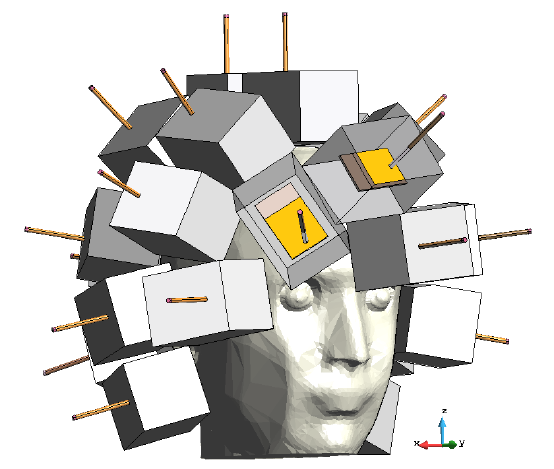
Figure 5. Computer-assisted design (CAD) model of the 3D microwave imaging system together with the anthropomorphic head phantom; two printed monopole antennas within the coupling medium bricks are highlighted in